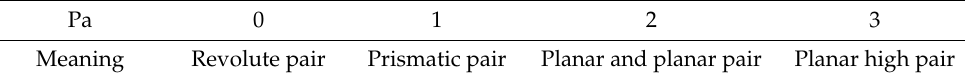
Table 1. Characteristics of kinematic pair.